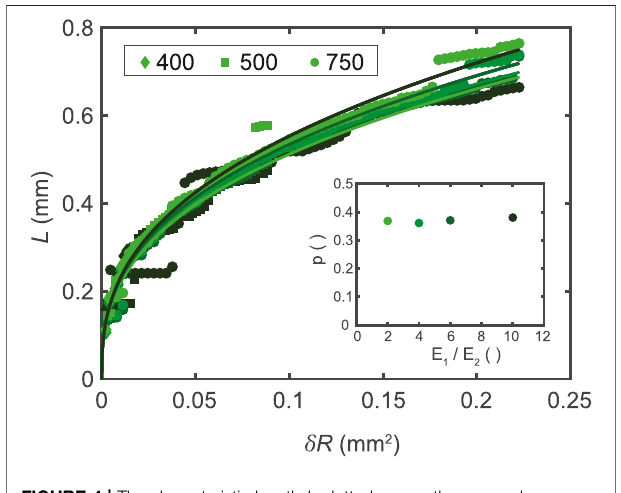
FIGURE 4 | The characteristic length L plotted versus the squared contact radius a 2 (cid:1) R δ for all three probe radii, fi tted using L (cid:1) b · ( R δ ) p with prefactor b (cid:1) 0.195andexponent p (cid:1) 0.37.Thelegendshowsthesymbolsfor the probe radius (µm). The inset shows p versus the ratio between the simulated moduli, with the lower modulus, E 2 (cid:1) 0.5 MPa and E 1 > E 2